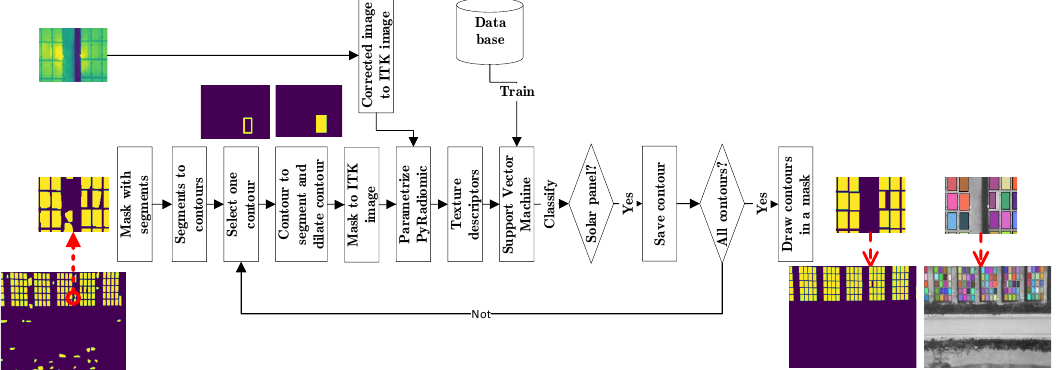
Figure 5. Panel classification with support vector